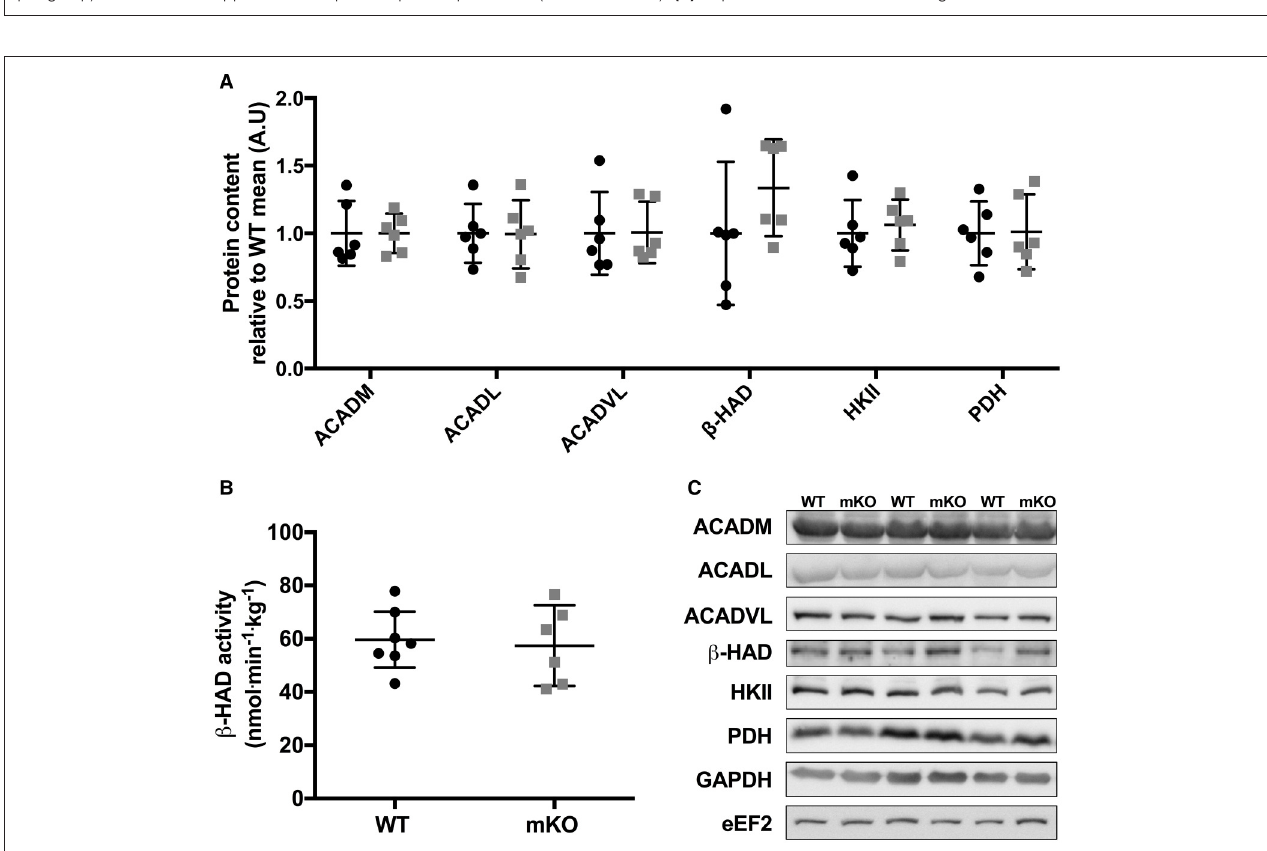
FIGURE 4 | Abundance of fat and carbohydrate metabolism proteins are consistent between p53 mKO (grey squares) and WT (black circles) mice. (A) WT and p53 mKO mice display similar protein content of proteins involved in fatty acid (ACADM, ACADL, ACADVL, and β -HAD) and carbohydrate (HKII and PDH) metabolism in gastrocnemius muscle ( p > 0.05; n = 6 per group). Similar data is apparent in triceps and quadriceps muscle (data not shown). (B) Similar β -HAD enzyme activity in triceps muscle of p53 mKO and WT mice ( p > 0.05; n = 6–7 per group). Similar data is apparent in gastrocnemius and quadriceps muscle (data not shown). (C) Representative immunoblot